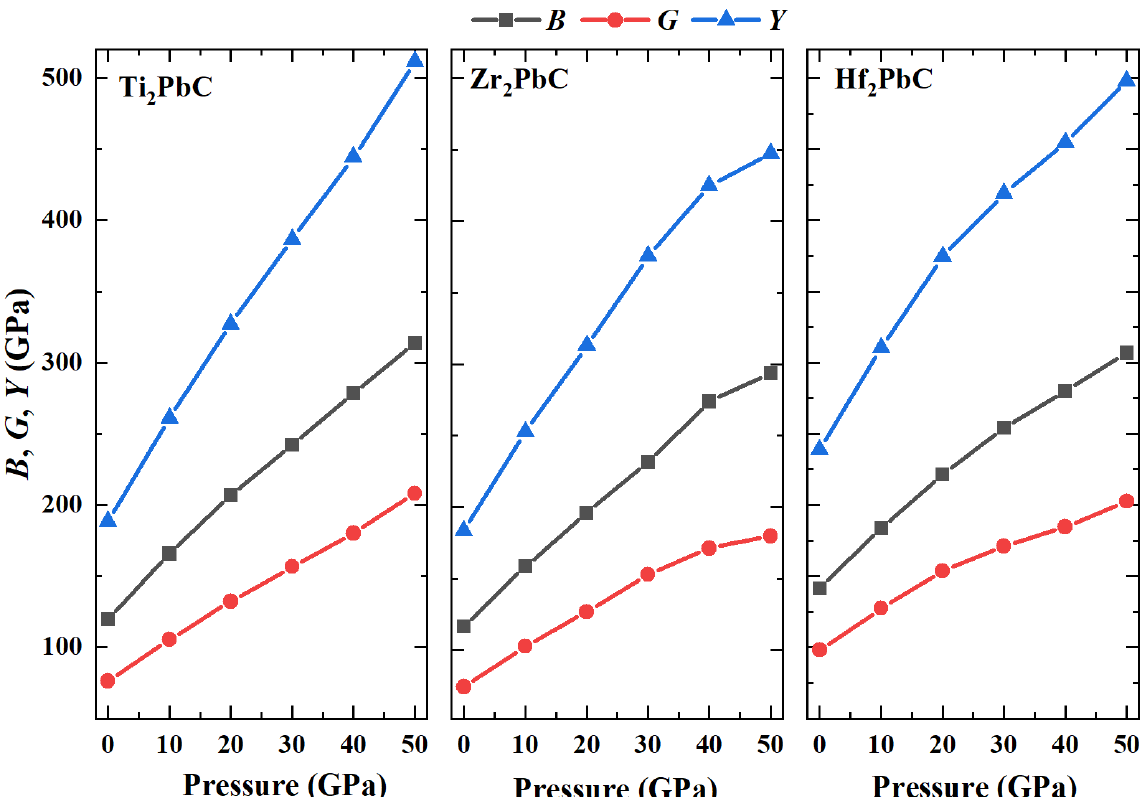
Figure 5. Variation of elastic moduli of M 2 PbC MAX phase (M = Ti, Zr, Hf) with pressure.